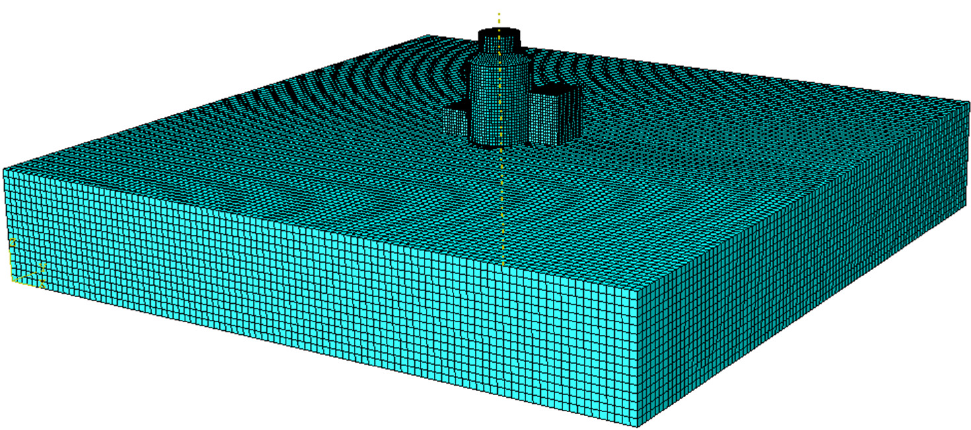
Figure 1. Finite element model of raft foundation and NPP structure.